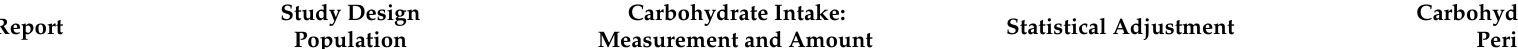
Table 1. Reports relevant to research question 1: Does a LC diet in pregnancy compromise the maternal-fetal glucose concentration gradient, suggested by reduced fetal growth and/or size at